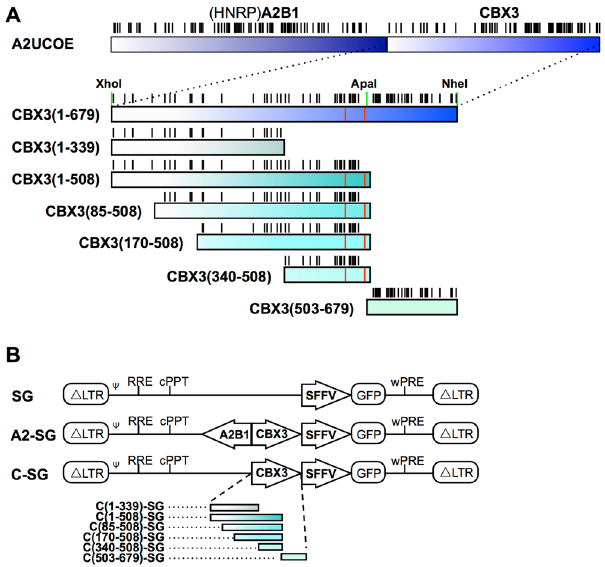
Figure 1. CBX3 subfragments and lentiviral vectors. ( A ) Schematic representation of the CBX3 element with its CpG-sites (black bars) and deleted splice sites (red bars) as well as the CBX3 subfragments obtained by PCR (CBX3(1-339) - CBX3(340-508)) and the CBX3(503-679) subfragment generated by restriction digestion with XhoI and ApaI. ( B ) Third-generation self-inactivating (SIN) lentiviral constructs expressing an eGFP cDNA from the spleen focus forming virus (SFFV) promoter in the absence or presence of either the 1.5 kb A2UCOE, the 679 bp CBX3 or any of the CBX3 subfragments. Abbreviations: Δ LTR: Long terminal repeat harboring the SIN mutation in the U3 region of the LTR; ψ : extended encapsidation signal; RRE: Rev-response element; cPPT: central polypurine tract; GFP: (enhanced) green fluorescent protein; wPRE: woodchuck hepatitis virus post- transcriptional Anti-silencing function of CBX3 subfragments in differentiated mESCs/iPSCs: correlation with CpG-sites. During differentiation stem cells undergo extensive epigenetic remodelling and euchromatic regions that served as favourable integration sites for lentiviral vectors may become heterochromatic, thereby